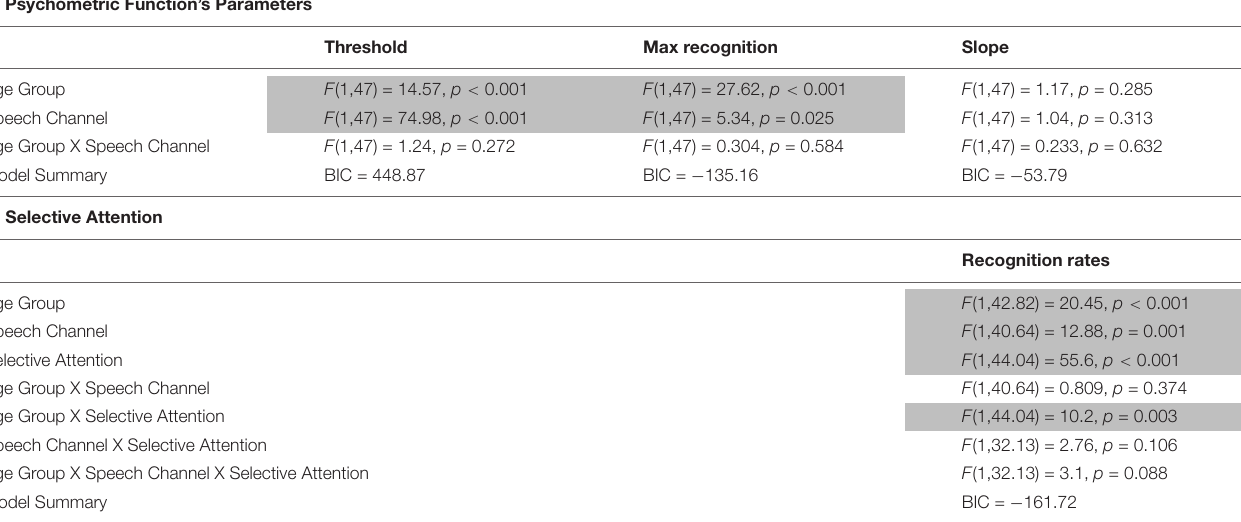
TABLE 1 | Model Summary and results of MLM analyses.